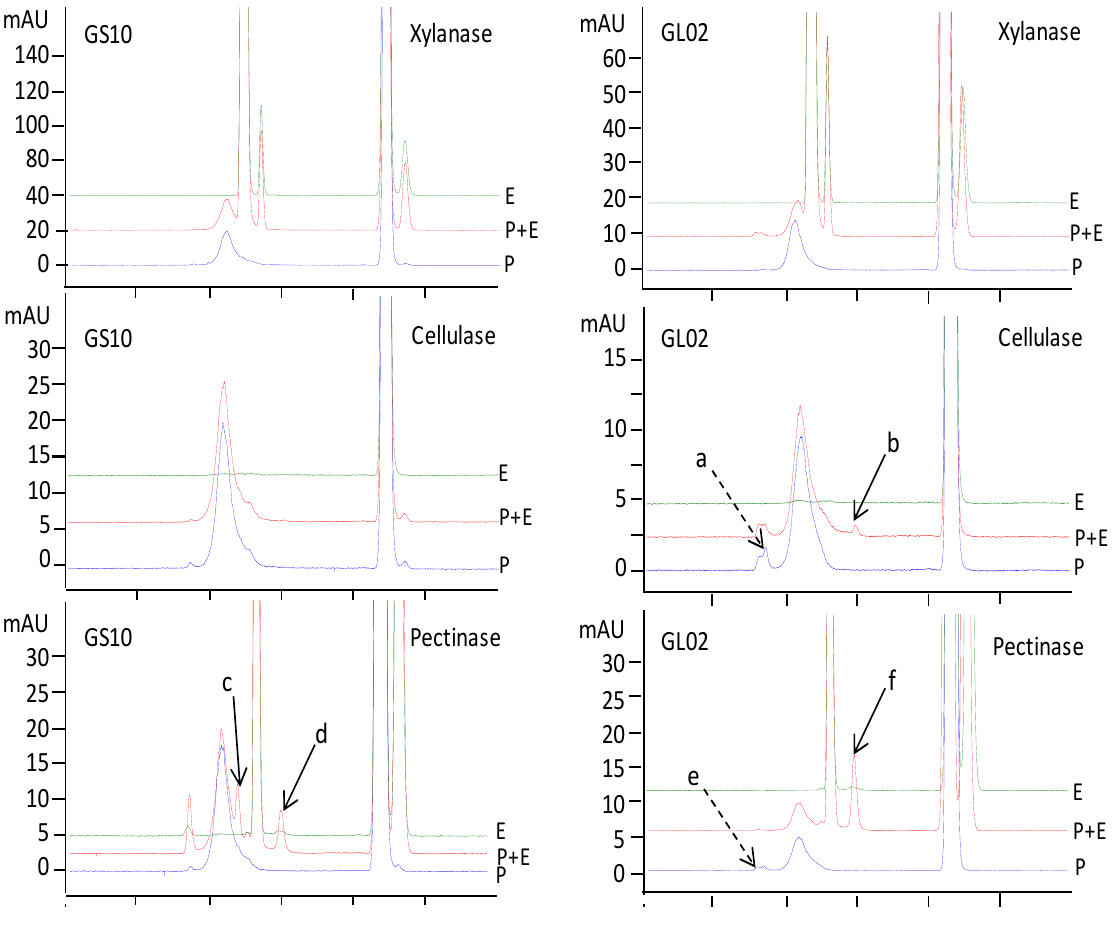
Figure 3. HPSEC-ELSD profiles of polysaccharides from G. lucidum (GL02) and G. sinense (GS10) treated with ( P+E ) or without ( P ) selected enzyme ( E